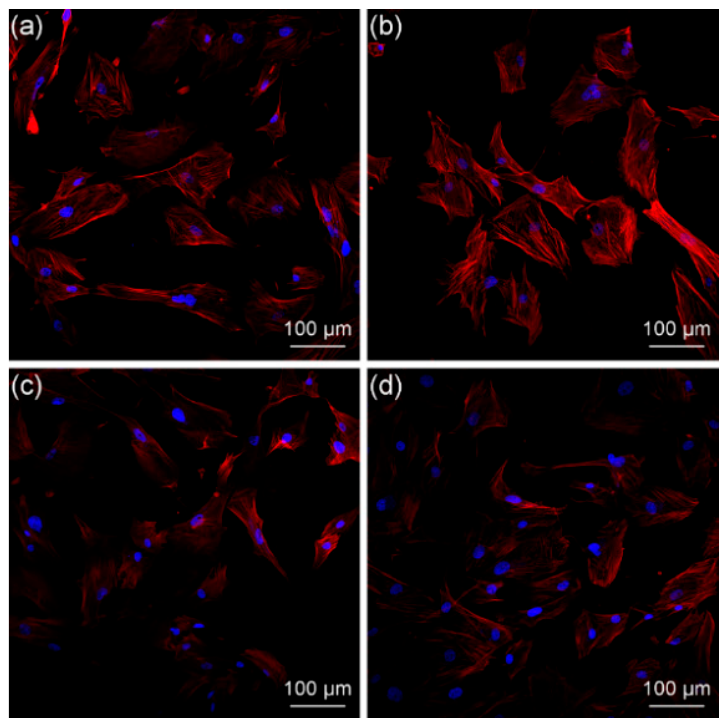
Figure 15. Cell viability of HGFs cultured on different materials for 72 h. A the same uppercase letters indicate that there was no significant difference between different materials ( p = 0.05). The data were significantly drawn from a normally distributed population at the 0.05 level.